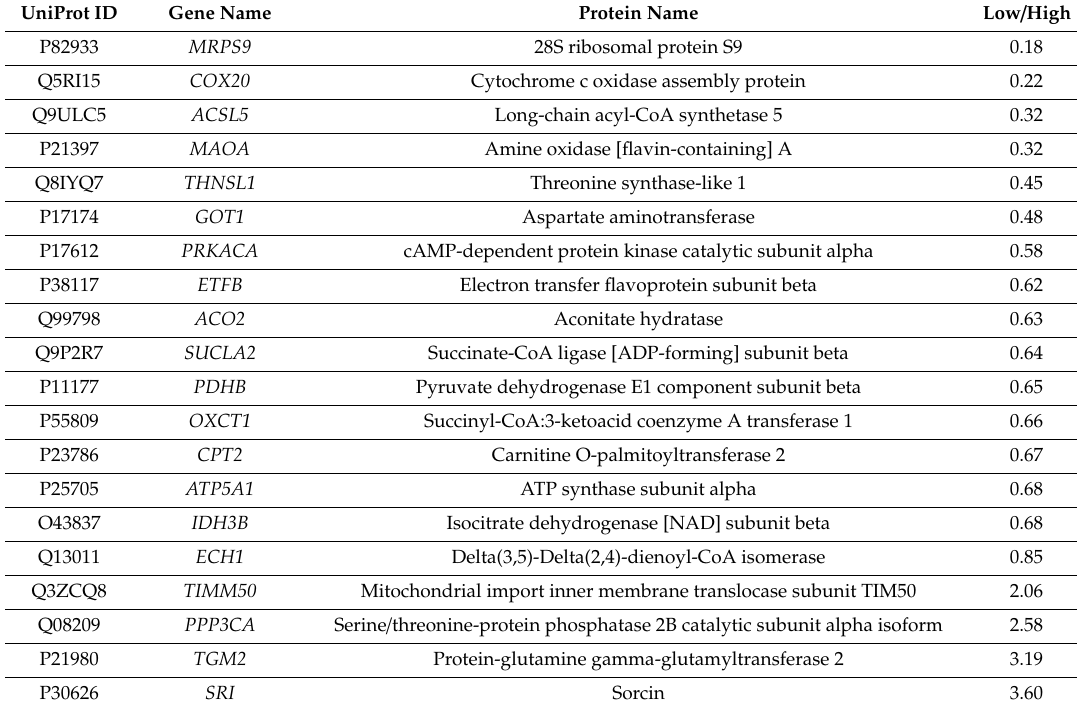
Table 2. Description of proteins involved in energy metabolism, which showed a significant p .value ( p < 0.05) in an unpaired, two tails t -test low vs high. Results are expressed as ratios of protein levels of severe asthenozoospermics to